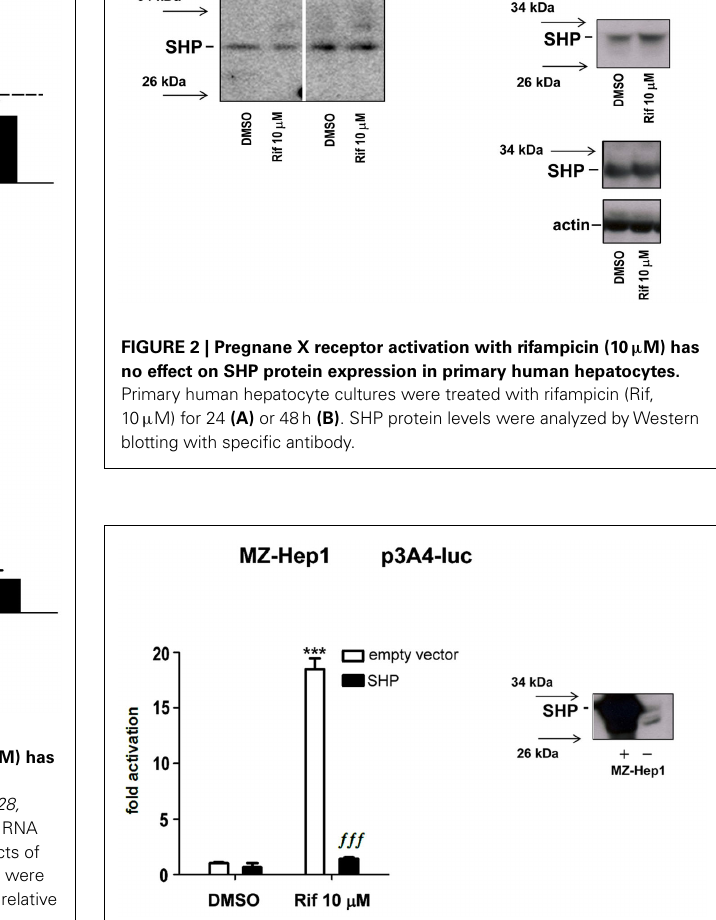
FIGURE 3 | Small/short heterodimer partner overexpression abolishes CYP3A4 transactivation in gene reporter assay in MZ-Hep1 cells. MZ-Hep1 cells were cotransfected with p3A4–luc reporter construct (200ng per well in 48-well plate), expression constructs for PXR (50ng per well), or expression construct for SHP (50ng, or appropriate amount of pSG5 empty vector). After 24h incubation with rifampicin (10 μ M), triplicates of cell samples were lysed and analyzed for firefly normalized to Renilla luciferase activity. Data represent the mean of three independent experiments and are shown as fold activation of normalized luciferase activity relative to solvent (0.1% DMSO) controls (set to 1). Statistically significant to vehicle (DMSO)-treated cells cotransfected under the same experimental conditions ∗∗∗ p < 0.01; statistically significant to rifampicin-treated cells (cid:2)(cid:2)(cid:2) cotransfected under the same experimental conditions p < 0.01 (Kruskal–Wallis test with Dunn’s Multiple Comparison post hoc test and ANOVA withTukey’s Multiple Comparison test). SHP protein levels in MZ-Hep1 cells were analyzed byWestern blotting with specific